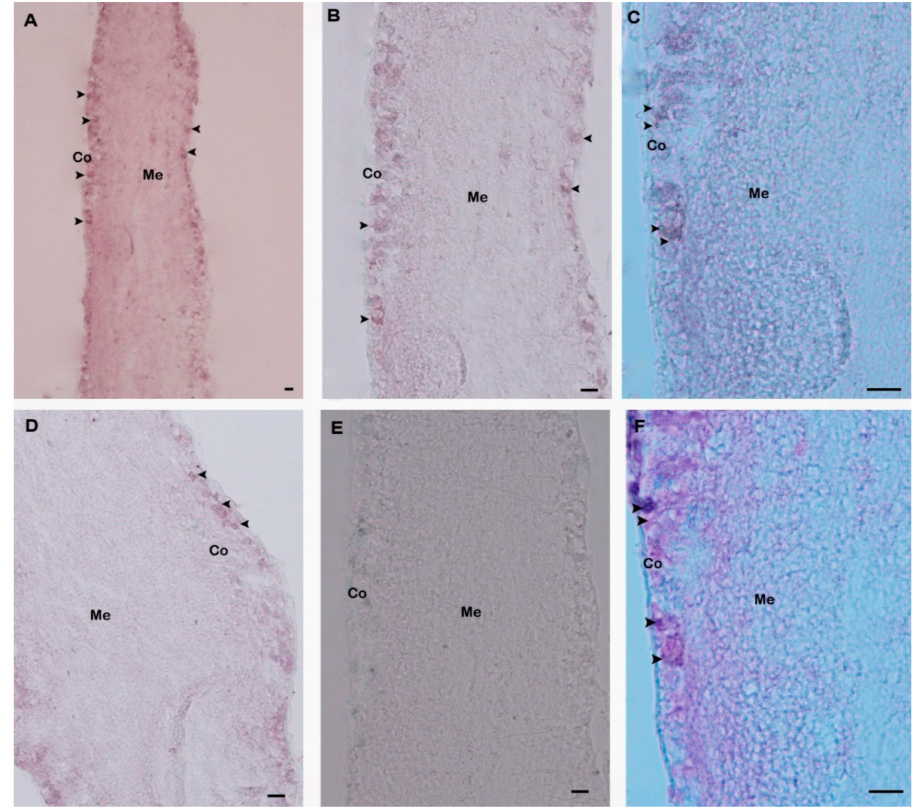
Figure 7. Distribution of GnRH-R mRNA in pleuropedal ganglion demonstrated by in situ hybridization. ( A ) Positive signals with an antisense probe are detected in the neurosecretory cells (arrows) of the cortex region; ( B ) Medium magnification of A; ( C ) High magnification showing hybridized GnRH-R mRNA in neurosecretory cells; ( D ) Medium magnification showing hybridization signal in the other part of cortex region; ( E ) Hybridized with the GnRH-R mRNA sense riboprobe showing no hybridization signal; ( F ) Fast red counterstaining showed hybridized neurosecretory cells. Co-Cortex; Me-Medullae. Scale bars, 100 µ